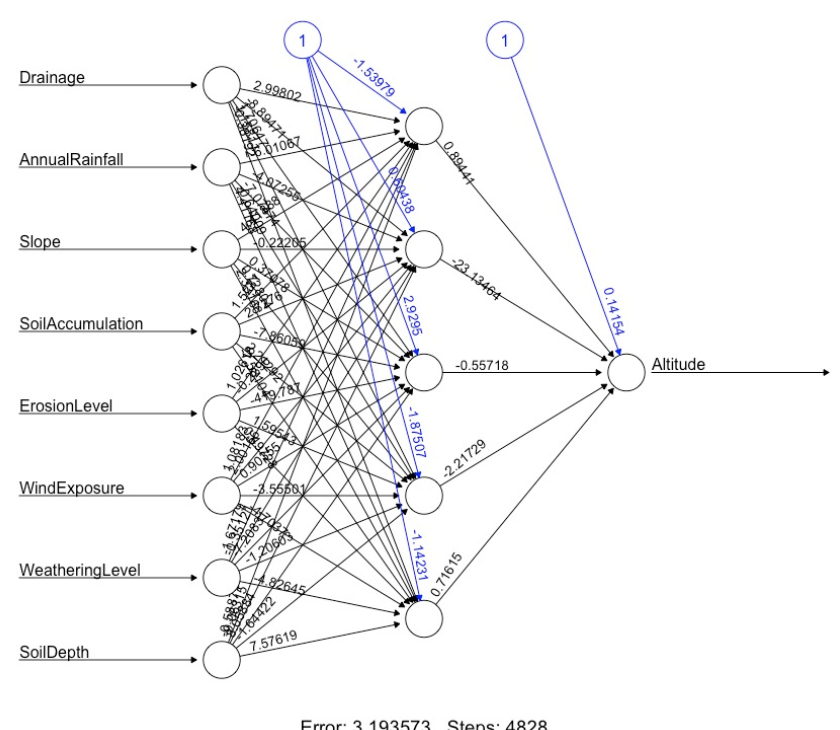
Figure 4. Multi − layer forward network with five hidden nodes to Altitude. Figure 4. Multi–layer forward network with five hidden nodes to